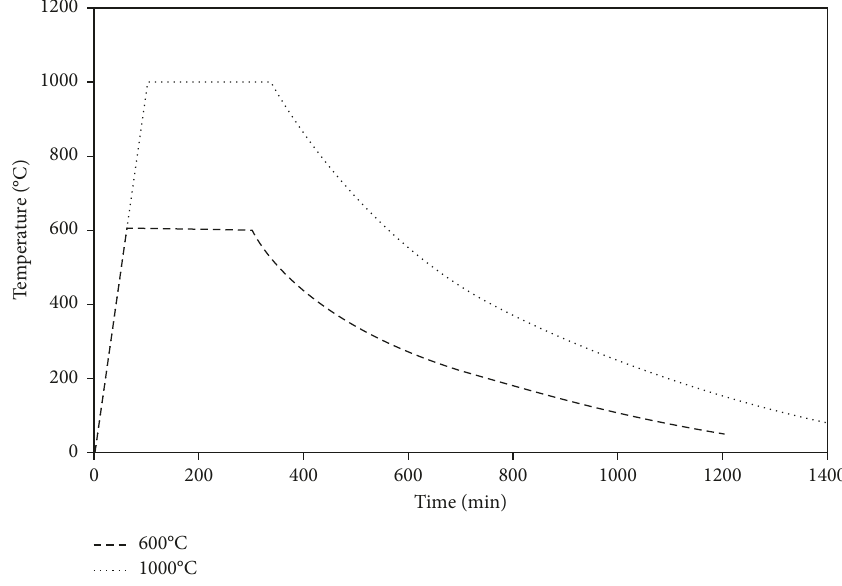
Figure 3: Illustration of used thermal loading (600 ° C and 1000 ° C).